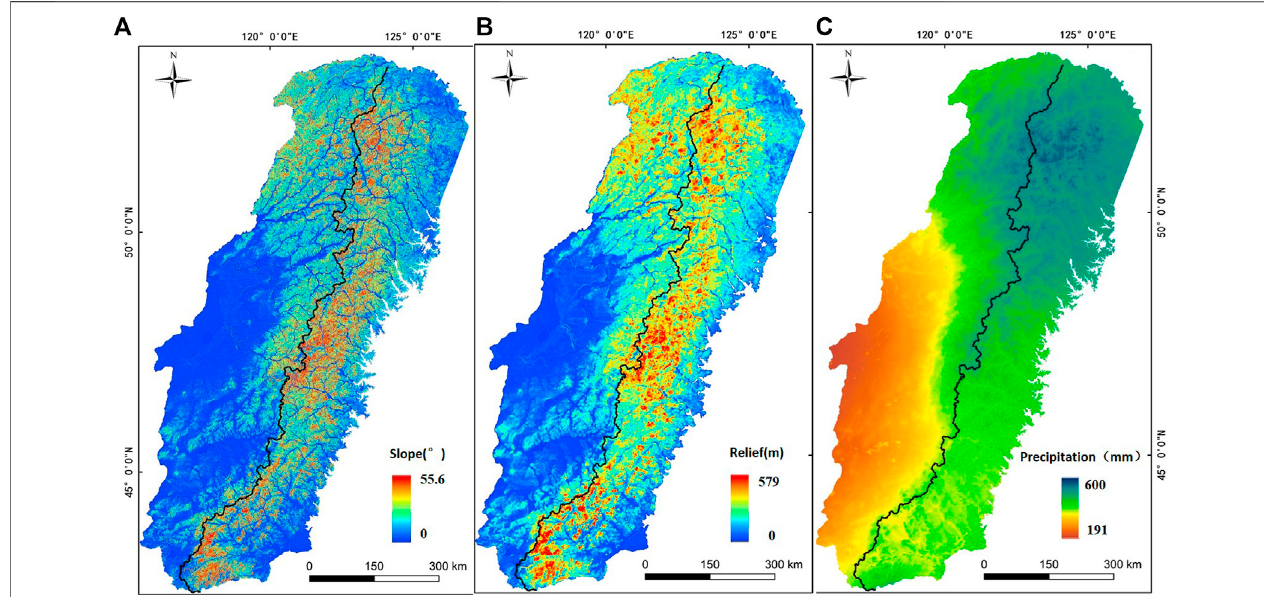
FIGURE8| SlopemapoftheGreaterKhinganMountains (A) .LocaltopographicreliefmapoftheGreaterKhinganMountains (B) .Averageannualrainfallmapofthe Greater Khingan Mountains (C) .